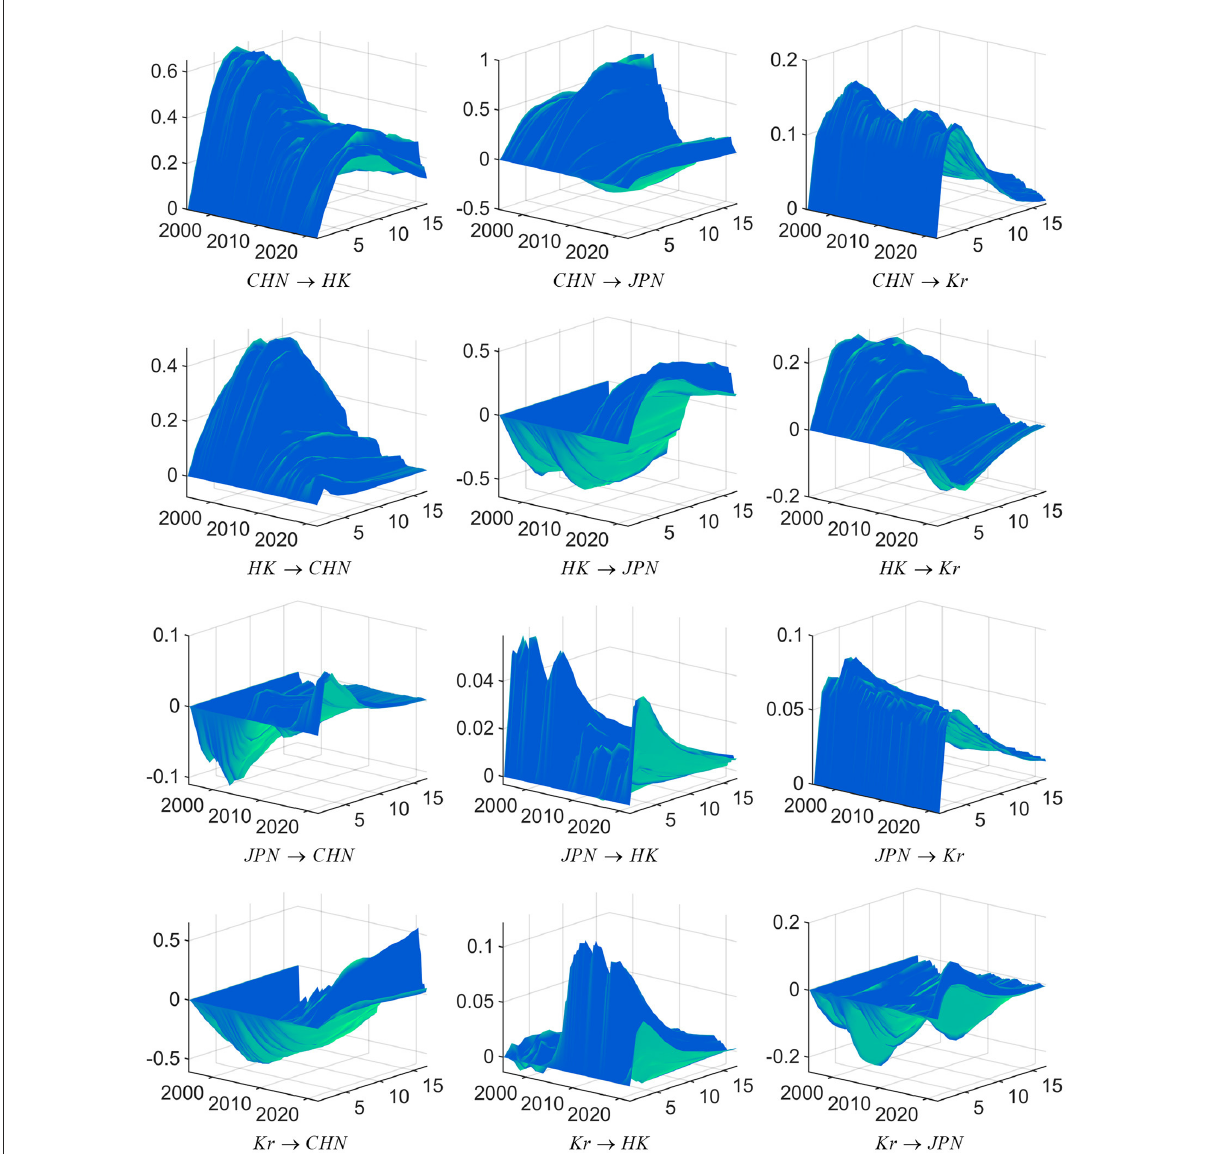
FIGURE4 Three-dimensional impulse response graph of return spillovers between the stock markets of China, Japan, and South Korea. Source: Author’s own calculations. CHN represents the China stock market, H.K. represents the Hong Kong stock market, JPN represents the Japan stock market, and Kr represents the South Korean stock market. Impulse response functions are to a 1 standard-deviation increase in the stock markets of China, Japan, or South Korea; each subfigure with the title of “ X → Y ” demonstrates the response of variable Y to a positive shock of variable X, wherein, X is an impulse variable, and Y is a response variable. One period in the figure denotes one